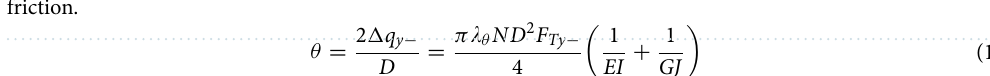
Figure 2. ( a ) Three loading paths of a tendon-driven CM. ( b ) Path of tension changes influenced by interface